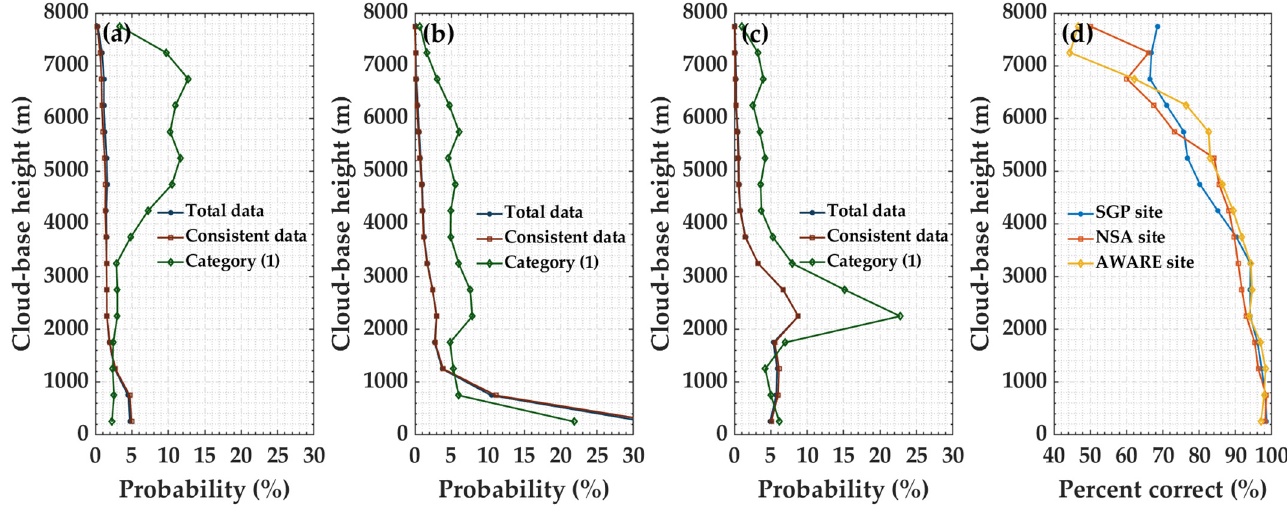
Figure 5. The proportion of total data, consistent data, and category (1) under different cloud-base heights of total testing set at ( a ) SGP site, ( b ) NSA site, and ( c ) AWARE site. ( d ) The PC of SGP site, NSA site, and AWARE site under different cloud-base heights.